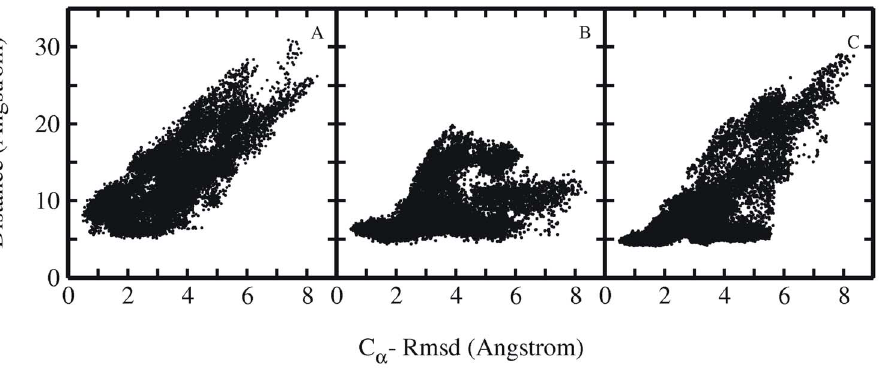
Figure 7. Rmsd and residue pair distance distribution. Distribution plots showing the correlation between RMSD C a and distance between the residue pairs (A) Tyr3-Pro19, (B) Trp6-Pro12 and (C) Trp6-Pro18. Each point represents one sampled state in all simulations starting from intermediate Trp-cage structures.